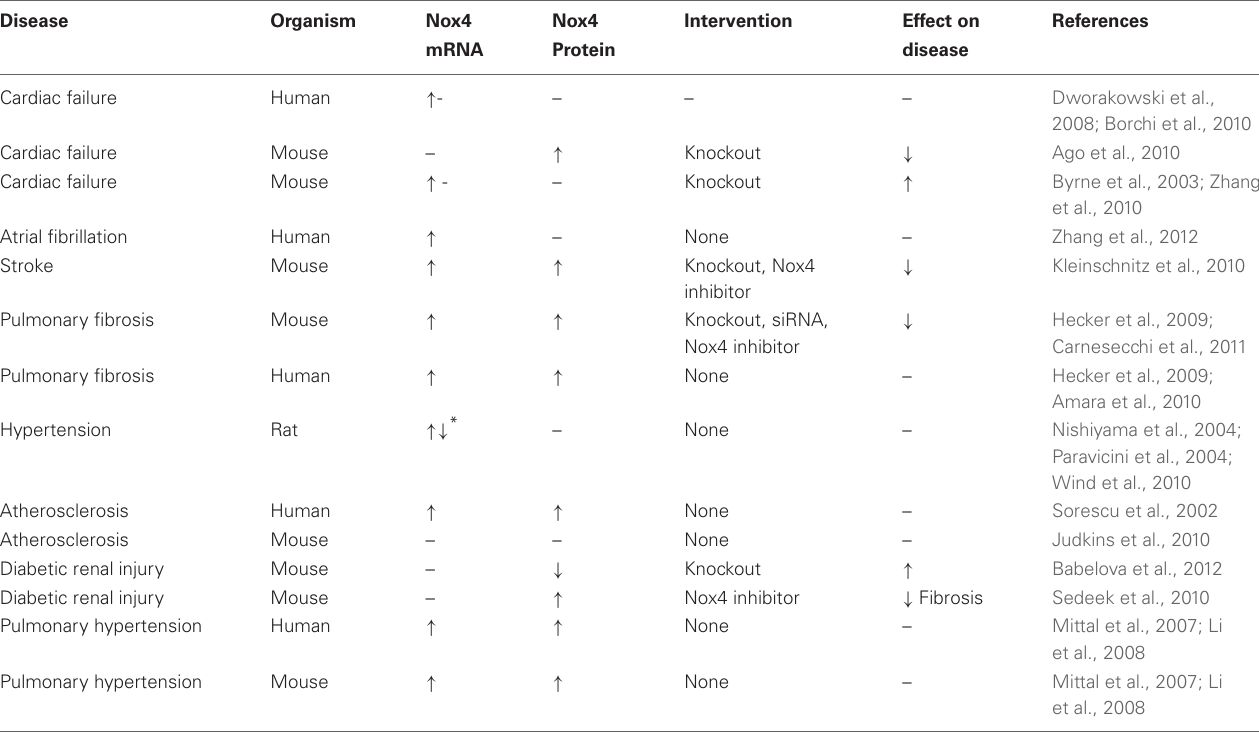
Table 1 | Changes in Nox4 mRNA and protein expression and the effect of targeting Nox4 on cardiovascular diseases.